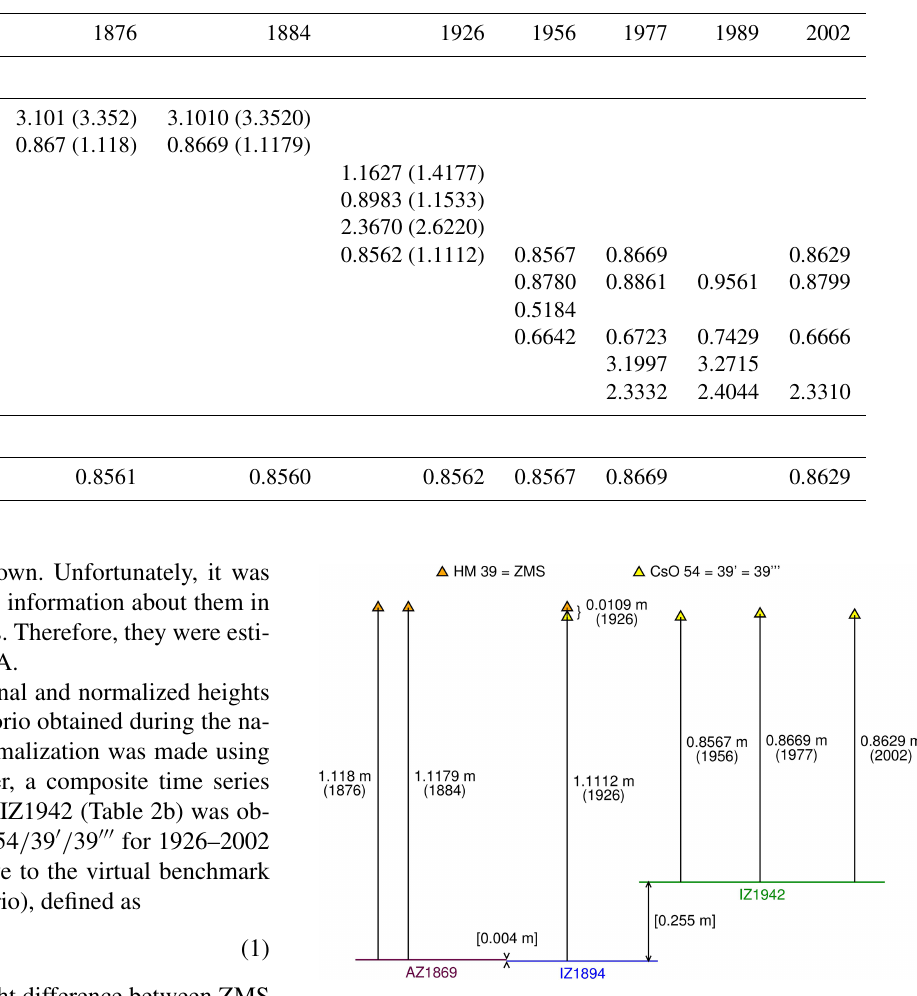
Figure 6. Heights of the benchmarks used to build the compos- ite time series; the year of the survey is in brackets. The zeros of the levelling networks are shown: Austrian Zero of 1869 (AZ1869), Italian Zero of 1894 (IZ1894), and Italian Zero of 1942 (IZ1942). The differences between the zeros have been estimated as discussed in Appendix